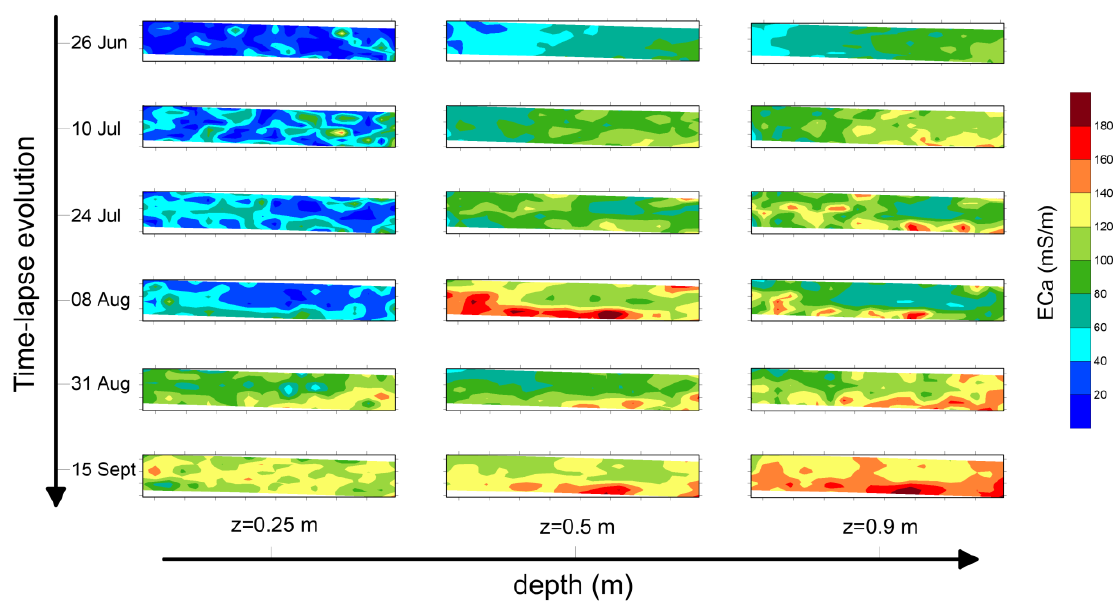
Figure 7. Maps of ECa recorded on the plot C1 for three depths (z = 0.25 m, z = 0.5 m and z = 0.9 m) and six temporal steps.